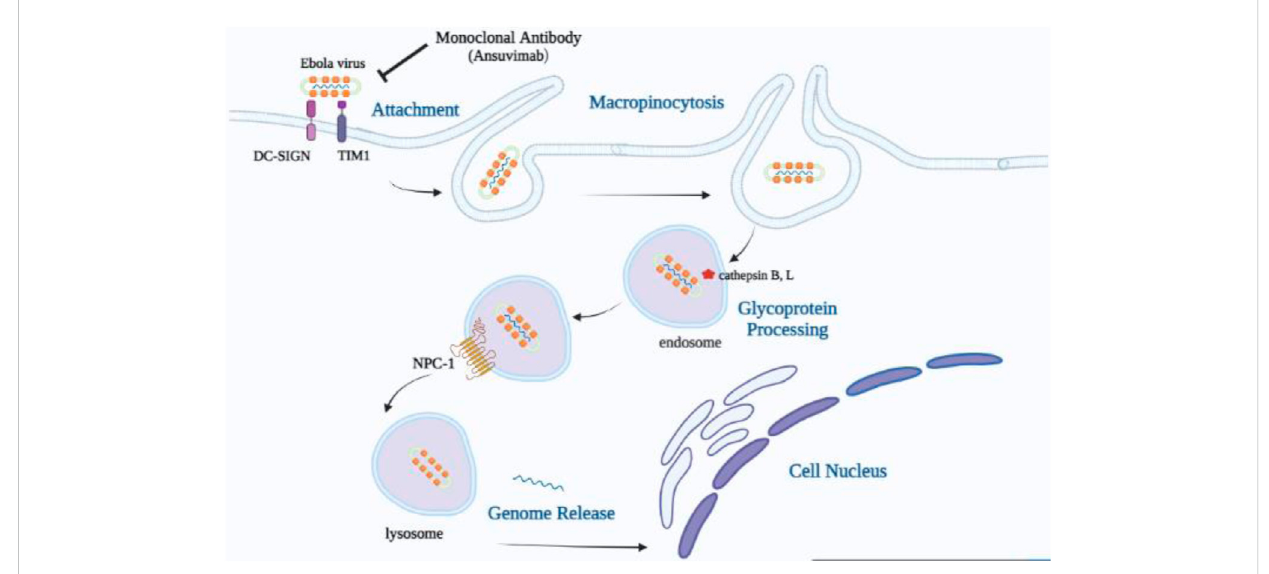
FIGURE 2 Mode of cellular uptake and entrance of the Ebola virus. Viral particles join with surface elements, T-cell immunoglobulin mucin (TIM) proteins, and dendritic cell-speci fi c intercellular adhesion molecule-3-grabbing nonintegrin-1 (DC-SIGN) and stimulate uptake through macropinocytosis, which contributes to the traf fi cking to endosomes. The receptor-binding domain in the GP1 core becomes visible in the low-pH endosome by cathepsin B, L ’ s removal of the mucin-like domain (MLD), and the glycan cap. Viral particles with exposed RBDs can engage the host cell receptor, Niemann – Pick intracellular cholesterol transporter-1 (NPC-1) protein, which results in the release of the viral genome into the cell cytoplasm and